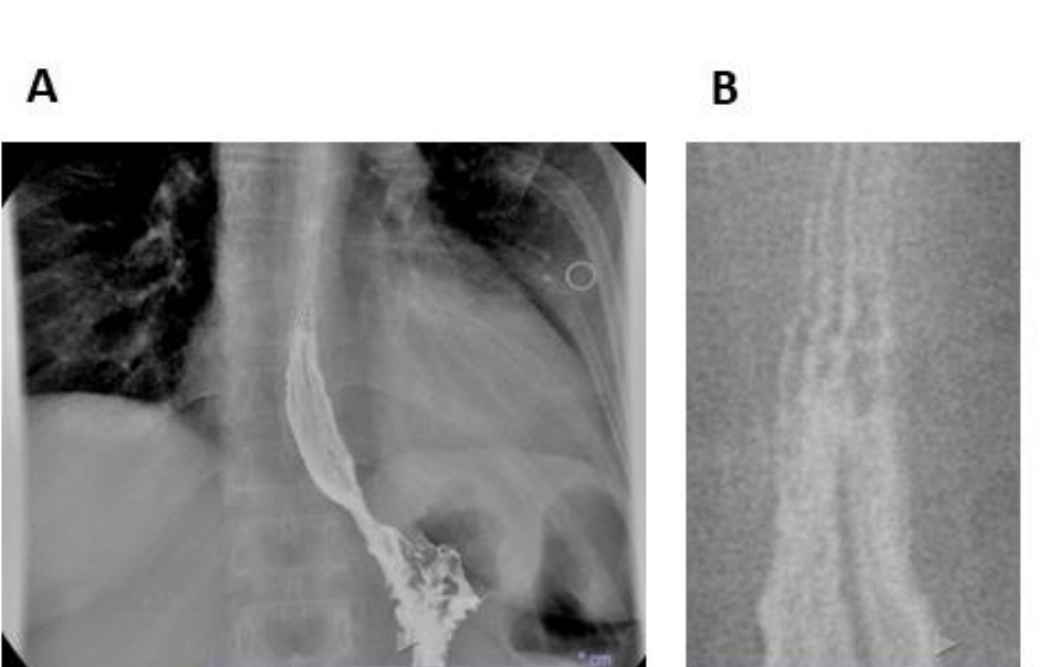
Figure 1: Videofluoroscopic swallowing study and esophageal transit evaluation. ( A ) Alterations of esophageal profile. ( B ) Detail of the proximal portion of barium column in A . Esophageal mucosa con- trasted with a low amount of barium shows some horizontal lines suggesting the presence of rings.